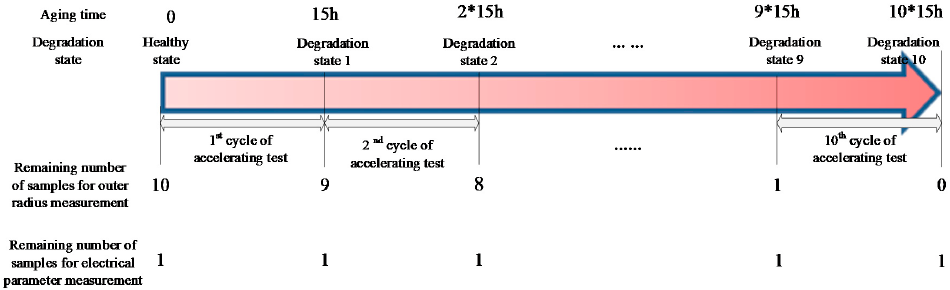
Figure 10. Description of the accelerated test process.